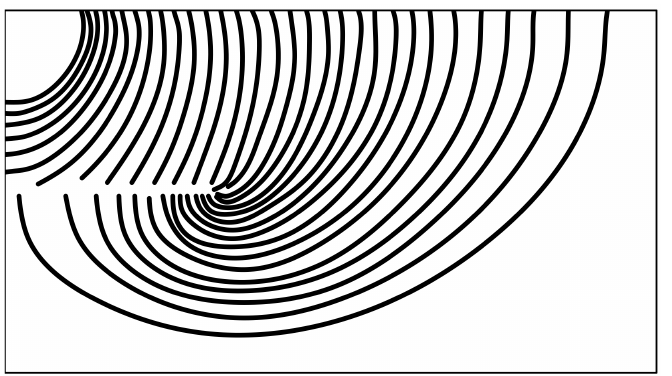
Figure 15. All the trace lines by b-spline interpolation.